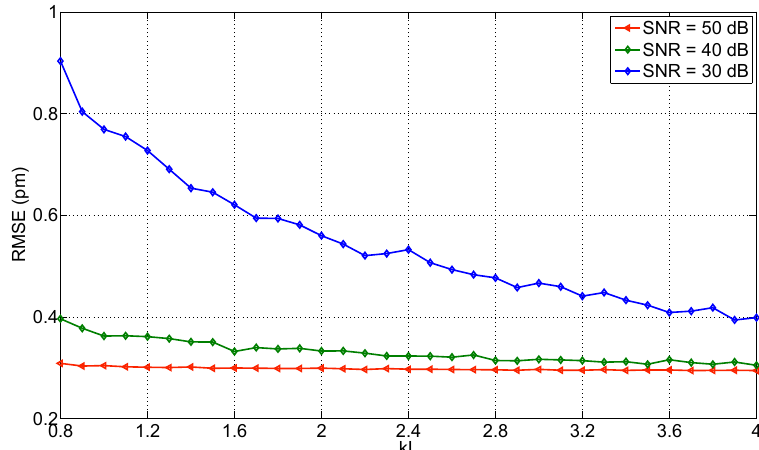
Figure 24. Dependence of the RMSE for the correlation-based tracking method on FBG strength kL , for different values of SNR. The FBG spectrum is sampled on a 1-pm grid.